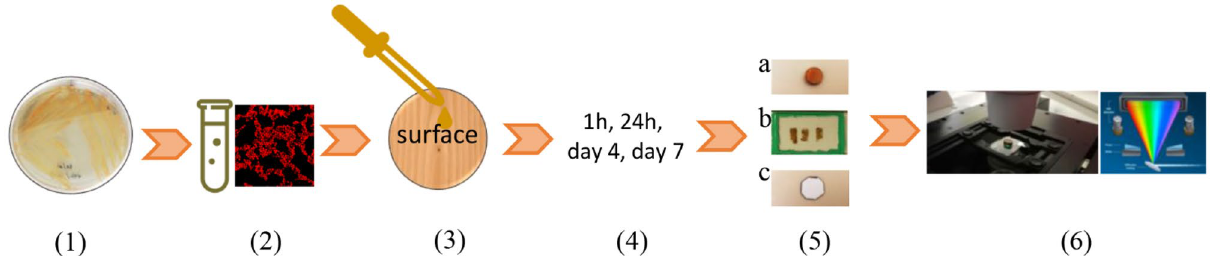
Figure 2. Experimental protocol used to characterize S. aureus bio-distribution on wood surface using spectral confocal laser microscopy (CSLM). Experimental steps: ( 1 ) Freshly cultured mCherry— S. aureus, ( 2 ) bacterial suspension prepared at 1.7 McFarland in PBS, ( 3 ) inoculation of wood disc surface, ( 4 ) different incubation time in dark, at room temperature, ( 5) (a) —wood disc on glass slide for direct non-destructive observation, ( b )— wood section mounting on slide in PBS, ( c )—melamine piece on glass slide for direct observation. ( 6 ) CSLM